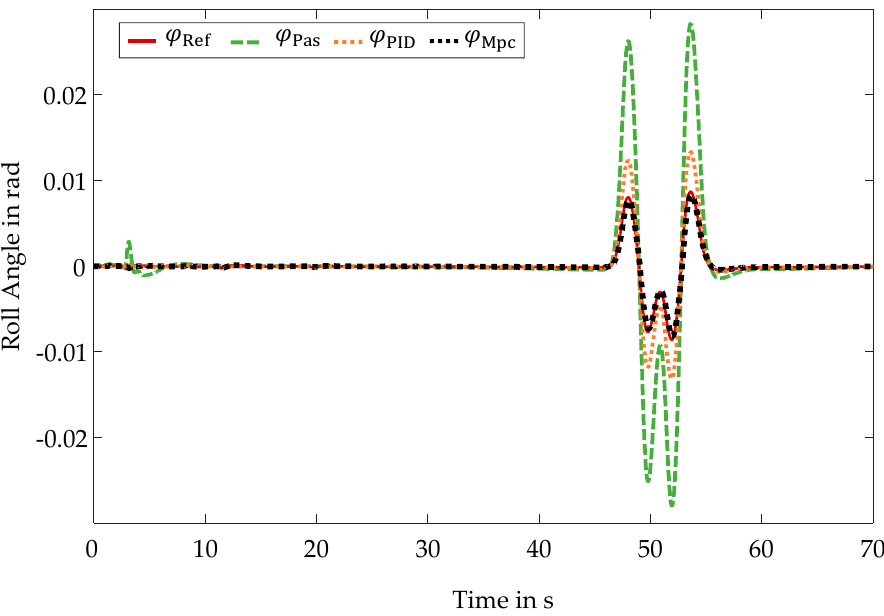
Figure 3. Control Quality Double Lane Change–Roll Behavior–Roll Angle Curves.